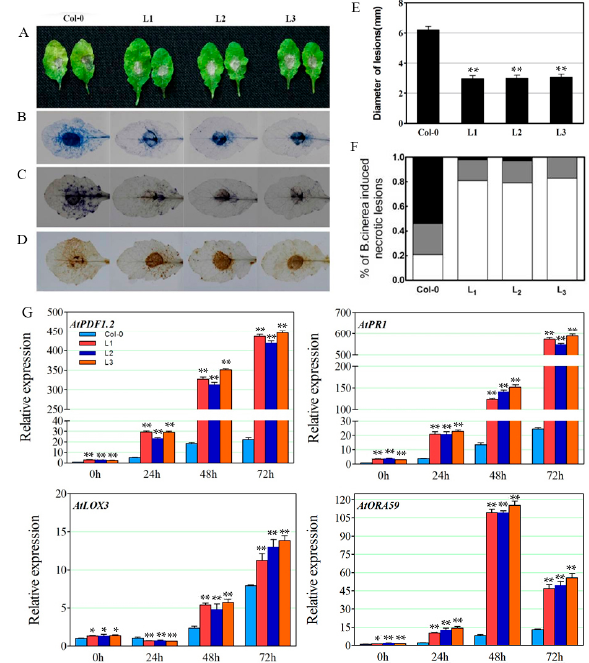
Figure 4. Overexpression of VaERF20 in A. thaliana conferred enhanced disease response to Botrytis cinerea inoculation. ( A ) The disease symptoms on transgenic A. thaliana and Col-0 leaves three days post-inoculation. ( B – D ) Histochemical staining for cell death ( B ), O 2 − ( C ) and H 2 O 2 ( D ) accumulation, respectively. Transgenic A. thaliana and Col-0 were observed in three independent experiments with 5–10 leaves in each. ( E ) Average lesion diameter of B. cinerea at 3 days post inoculation (dpi). Data represent the means ± standard deviation from three independent experiments with at least 60 leaves per sample. Asterisks indicate statistical significance (** p < 0.01, one-way ANOVA) between transgenic A. thaliana and Col-0. ( F ) Symptoms on transgenic A. thaliana and Col-0 leaves at 3 dpi following B. cinerea inoculation by defining three lesion diameter sizes (<40% white parts, 40–80% grey parts, >80% black parts). ( G ) Expression analysis of defense-related genes in transgenic A. thaliana lines and Col-0 plants at 0, 24, 48 and 72 h post inoculation (hpi) with B. cinerea . Data represent the means ± standard deviation from three independent experiments. Asterisks indicate statistical significance (* 0.01 < p < 0.05, ** p < 0.01, one-way ANOVA) between transgenic A. thaliana and Col-0 samples.